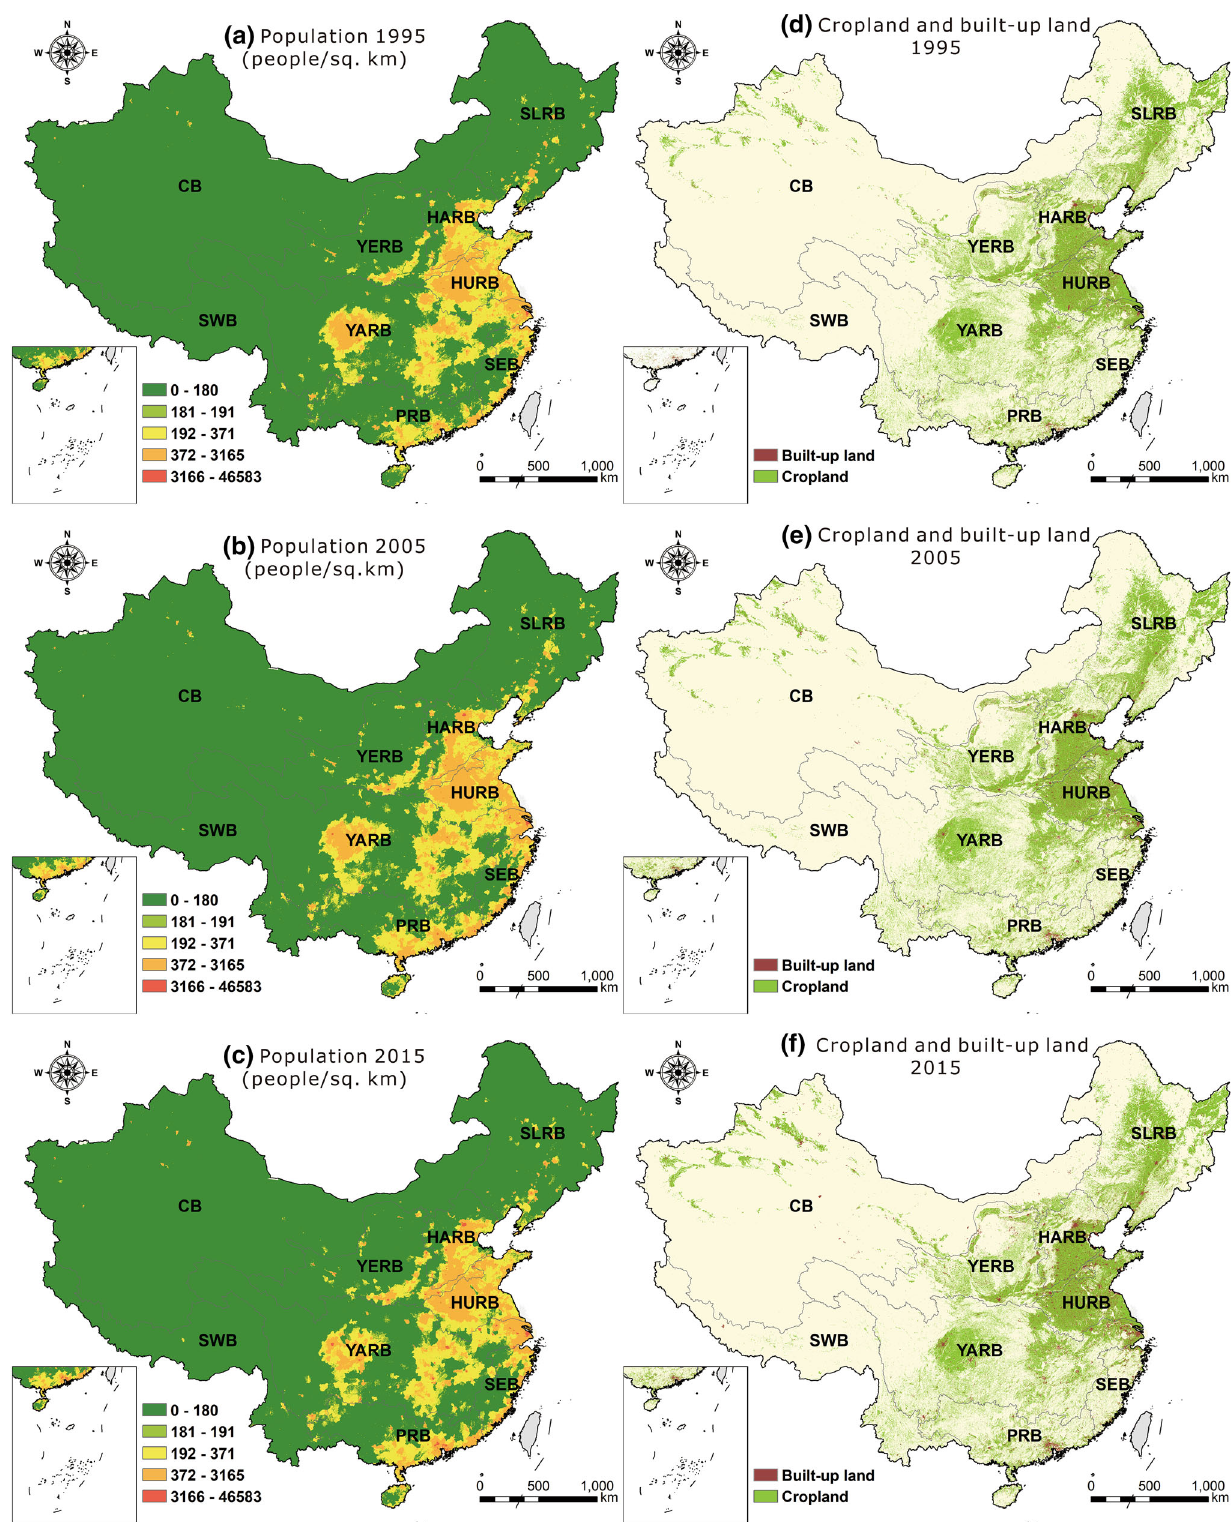
Fig. 1 Population and land-use in China for the years 1995, 2005, and 2015. CB Continental basin, YERB yellow river basin, HARB Haihe river basin, SLRB Songhua–Liaohe river basin, SWB southwest